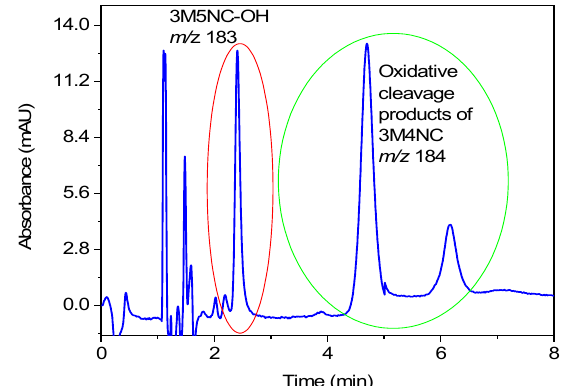
Figure 5. Chromatogram recorded at 388 nm for the reaction mixture of 0.1 mM 3MC and 1 mM NaNO 2 under sunlight conditions is comparable to the one from our previous study [28]. The peak at 2.5 min with the m / z ratio of 183 corresponds to 3MC5NC-OH, while the peak at 4.5 min with the m / z of 184 corresponds to oxidative cleavage products of 3M4NC.